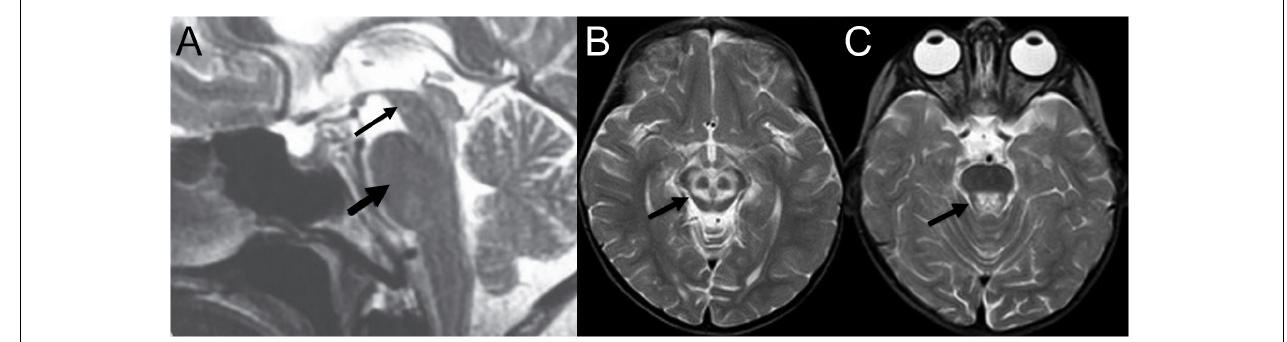
FIGURE 6 | Examples of neuroradiological imaging pareidolia in central nervous system diseases. (A) Midbrain atrophy (thin arrow) without atrophy of the pons (thick arrow) results in the appearance of a hummingbird in patients with progressive supranuclear palsy. (B) Increased signal at the tegmentum with decreased intensity at the superior colliculi appears to represent a large panda head (arrow), and (C) a second head of a smaller panda is visible at the pons ( A is modified from Verma and Gupta, 2012; B,C from Sonam et al., 2014).